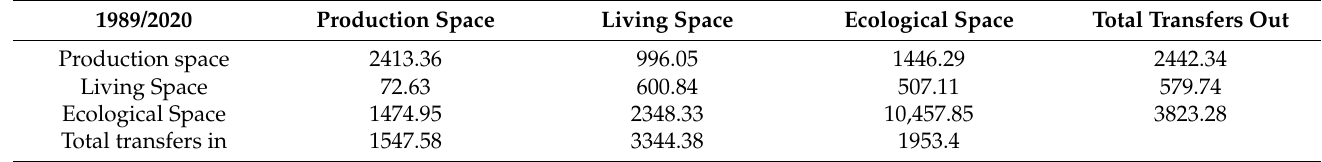
Table 5. Spatial transfer matrix in the PYL area from 1989 to 2020 (km 2 ).